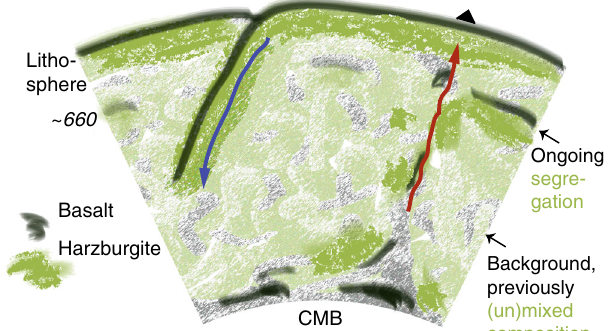
Fig. 7 Cartoon of thermo-chemical mantle convection. Brighter colors represent compositional mixing and unmixing by currently active convection, while the faded colors symbolize older heterogeneity in the background mantle.When a cold oceanic plate (blue arrow) subducts deep into Earth ’ s mantle, its rheological strength prevents the separation of basaltic crust and harzburgitic melt residues. Once heated in the deep mantle, however, their differential density can lead to separation and, over time, the formation of a mechanically mixed mantle. Some basalt may segregate on top of the core-mantle-boundary (CMB) because at those pressures a basaltic composition is denser than harzburgite. In low- viscosity upwellings (red arrow), segregation can also occur near 660 km depth because harzburgitic components remain in a dense lower-mantle composition longer than basalt. Over time this can form laterally heterogeneous harzburgitic and basaltic accumulations around 660 , replenished at upwellings and disrupted by